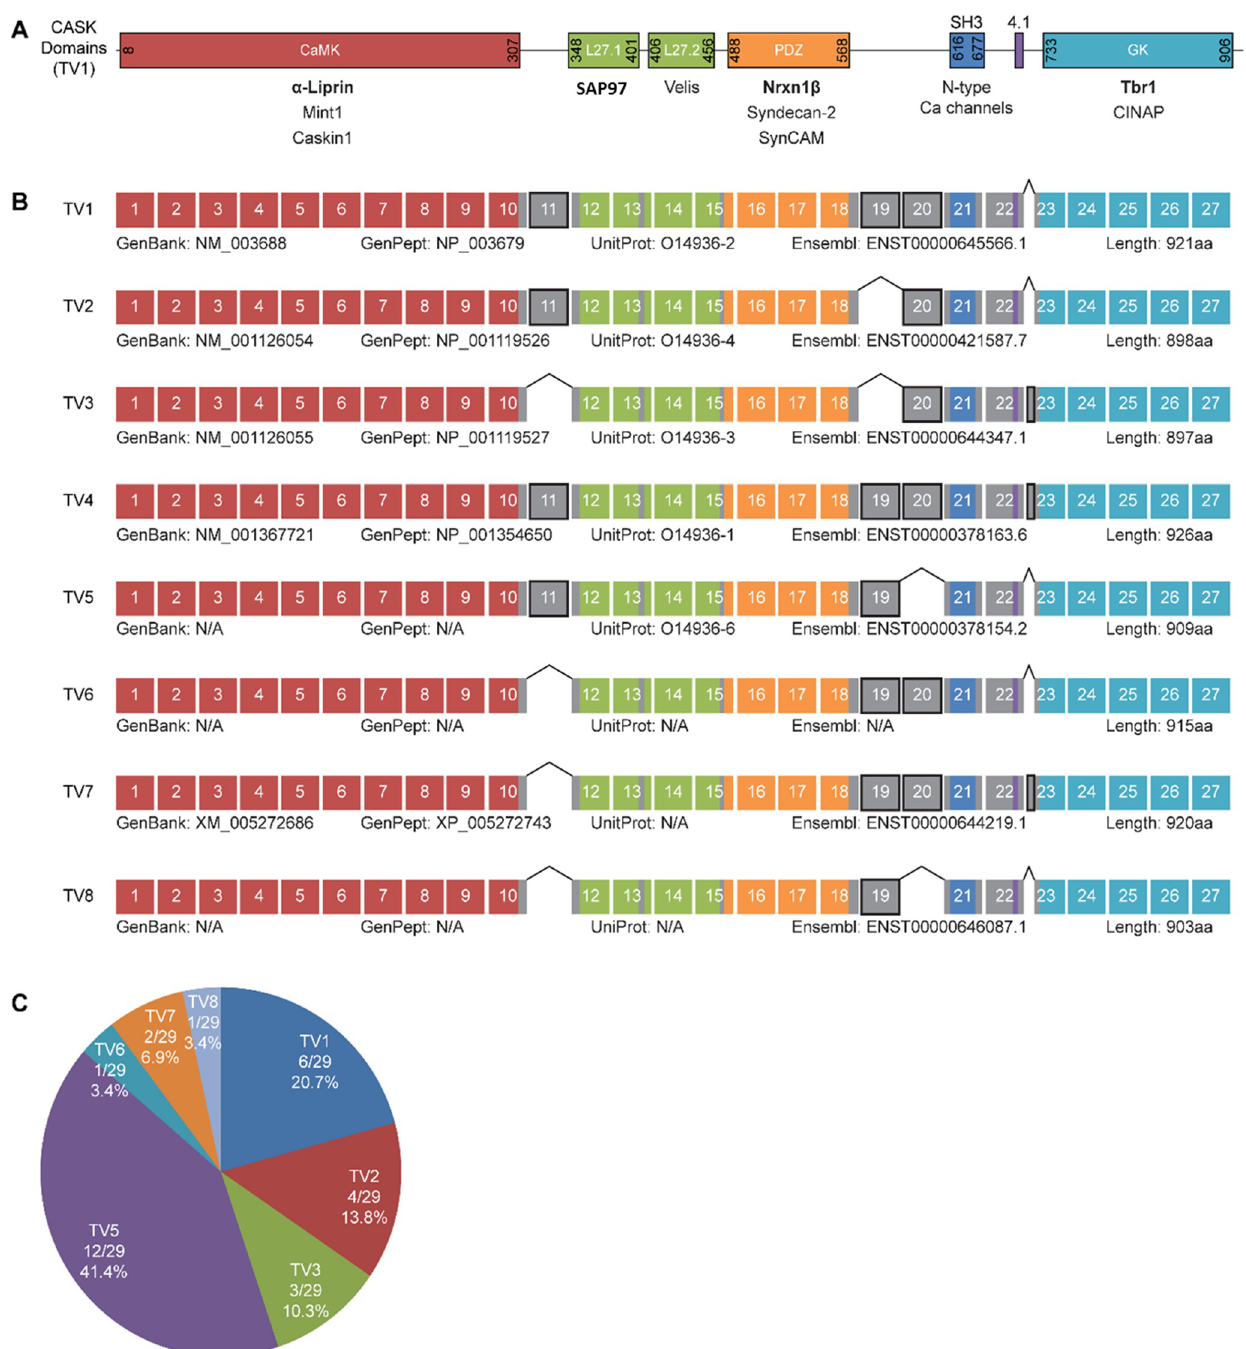
Fig 1. Variants of CASK expressed in the fetal human brain. A: The domain structure of the CASK protein with a selection of interaction partners for the respective domains. Interaction partners tested here are shown in bold. B: Result of the analysis of fetal human brain RNA by RT-PCR, followed by subcloning of PCR products and Sanger sequencing shows the exon structure of human variants of CASK. CASK TV4 was not present among the tested clones but added in the figure, as it is listed as known human variant at GenBank. The alternatively spliced exons are indicated in grey and encode for linker regions between defined protein domains. C: Relative abundance of CASK variants among the 29 tested clones. CASK TV5, corresponding to Cask from rat in terms of exon usage, accounted for 41.5% of all transcript variants and was the most abundant variant.